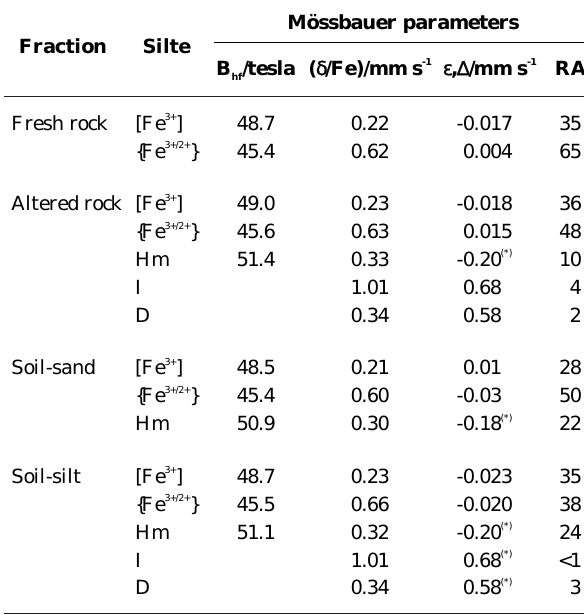
Table 3. Room temperature Mössbauer parameters of the whole untreated fractions